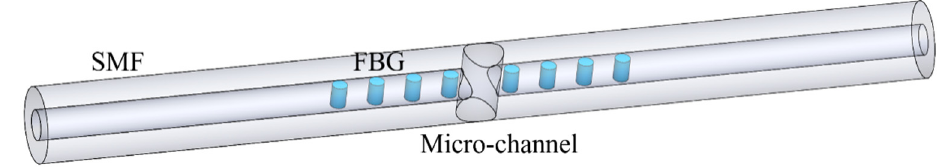
Figure 9. Schematic diagram of the designed PS-FBG, modulated by a micro-channel. Combining femtosecond laser micromachining technology with fiber fusion technol- ogy, PS-FBG with high refractive index sensitivity can be fabricated by making bubbles in the grating on FBG [61]. Firstly, an excimer laser is used to process an FBG with a central wavelength of 1578 nm using the phase mask method, and the FBG is cut from the mid- point by a fiber cutter. Then, a micropore is processed in the center of a cutting section by a femtosecond laser, and the two sections are spliced. When the air in the micropore is suddenly heated, it will expand into a bubble. Finally, a micro-channel through the center of the bubble was fabricated by fs laser drilling technology. Micro-channels can make the liquid enter the bubble and cause a change of phase shift. The schematic diagram of the device is shown in Figure 10. The length of FBG is 5 mm. The diameters of bubble and micro-channel are about 50 μ m and 14 μ m, respectively. A phase shift peak around the center of FBG stop band at 1578.8 nm with FWHM of 30 pm. In the RI range of 1.400–1.420, the refractive index sensitivity is 9.9 nm/RIU. The tem- perature sensitivity of the phase shift peak is 10.19 pm/°C, and the temperature has little effect on the phase shift. This device has great sensing potential. Different sensing func- tions can be realized by injecting liquids with different characteristics into a bubble. Figure 10. Schematic diagram of the designed PS-FBG in single-mode fiber. The insertion of hollow fiber (HCF) into the FBG gate area can also achieve good results [62]. Firstly, a hollow fiber with an inner diameter of 75 um is spliced between two pieces of SMF, then a pair of FBGs are inscribed in the SMF on both sides of the HCF by femtosecond laser line-by-line method. The two FBGs have the same Bragg resonant wavelength of 1550 nm. Finally, a pair of microchannels with a diameter of 15 um is drilled on the hollow fiber by femtosecond laser. The device is shown in Figure 11. The hollow fiber introduces a special phase shift in the FBG, and the microchannel can make the external air enter the hollow cavity. The change of air pressure will change the refractive index of air, resulting in the change of phase shift. Through the experimental test, in the range of 0–2.25 MPa, the change of phase shift wavelength is linearly related to the change of gas pressure. When the hollow cavity length is 88.3 μ m, the gas pressure sensitivity achieved 1.22 nm/Mpa. In addition, the tem- perature sensitivity of the phase shift peak is 8.92 pm/°C. Figure 11. Schematic diagram of the PS-FBG, modulated by a hollow cavity.